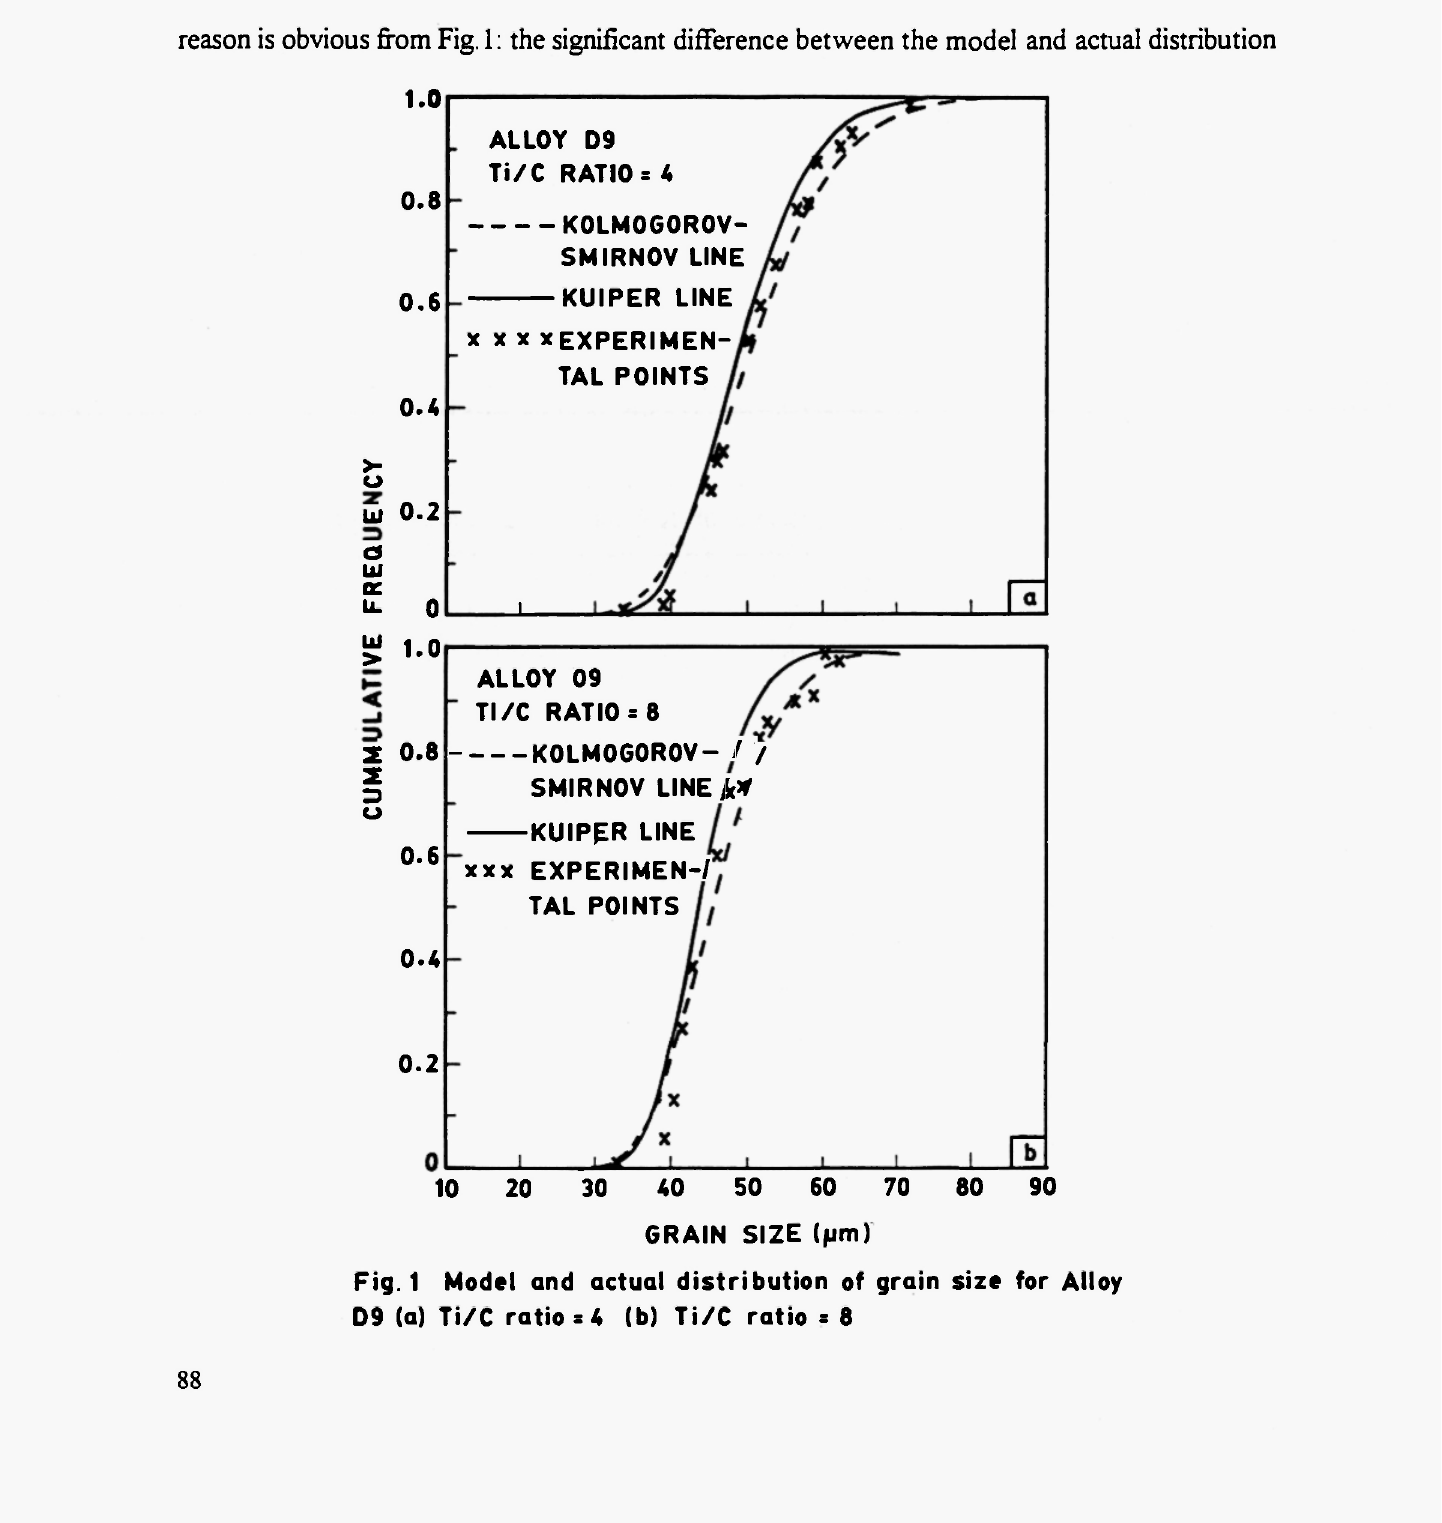
Fig. 1 Model and actual distribution of grain size for Alloy D9 (a) Ti/C ratio = 4 (b) Ti/C ratio =